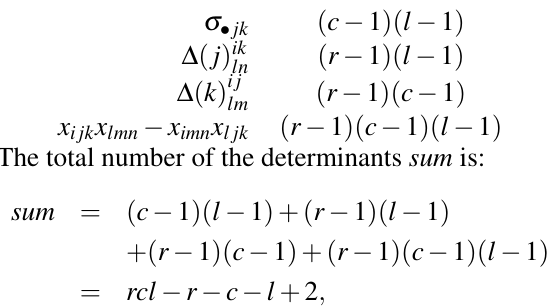
Figure 2: Geometrical Structure of 2 × 3 × 3 Contingency